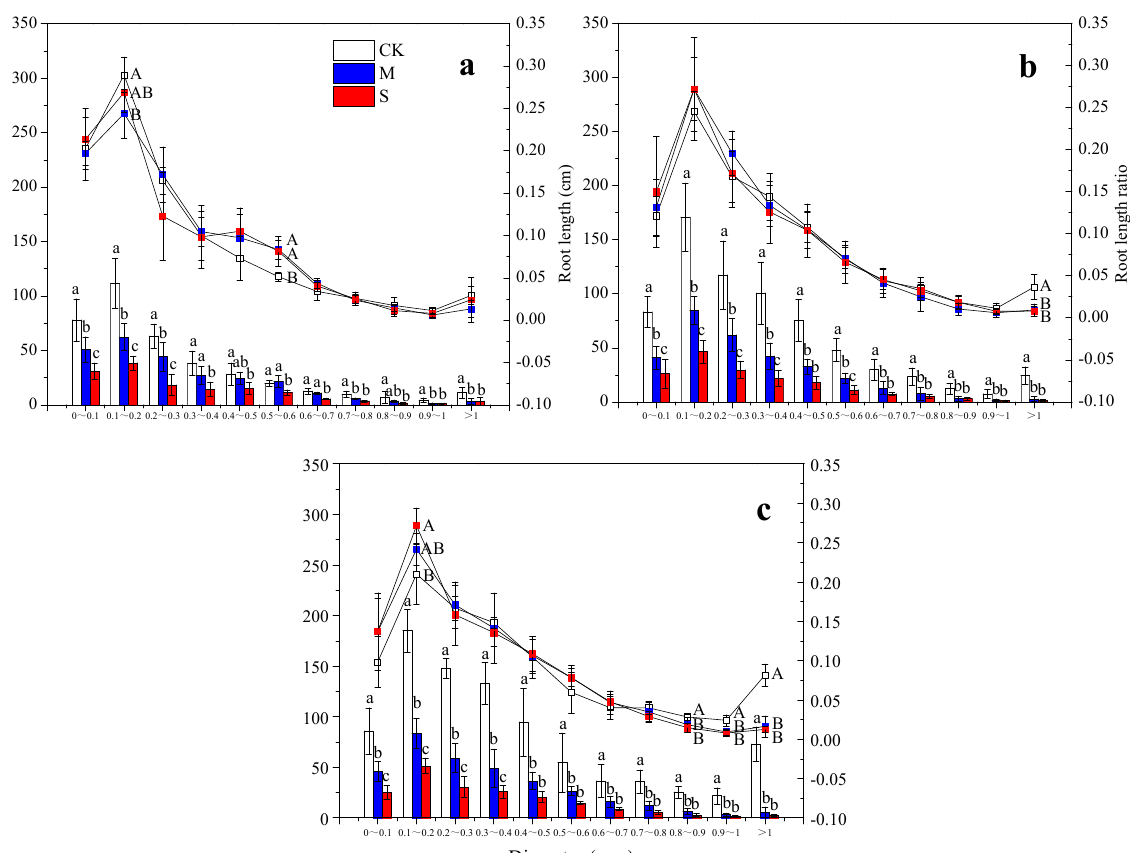
Figure 5. Root length distribution and the RLR of bamboo roots with different diameters under drought stress. The different capital letters denote significant differences in the RLR between treatments ( p < 0.05), and the different lowercase letters denote significant differences in root length between treatments ( p < 0.05). The histograms represent the root length, and the line charts represent the RLR. ( a ): 30th day; ( b ): 60th day; ( c ): 90th day.